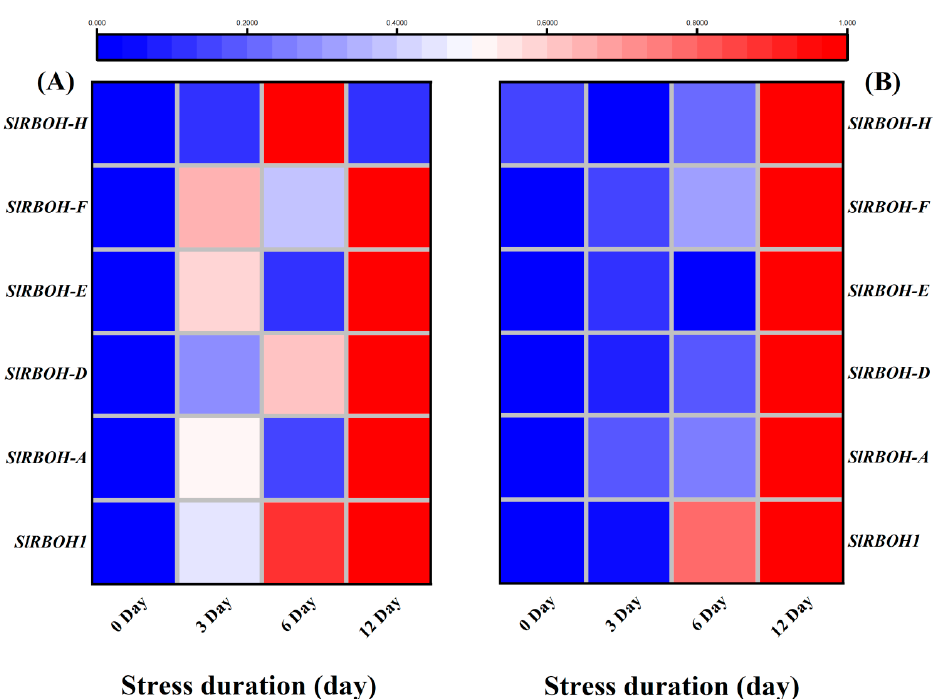
Figure 9. Heatmap of selected genes-related RBOHs (respiratory burst oxidase homolog proteins). The relative expression level was quantified from tomato ( A ) Leaves; ( B ) roots after 12days of salt treatment. The scale (Log 2 of the mean values after normalization; n = 3) shows the increase in relative concentrations from blue to red color, compared to control (0 h).